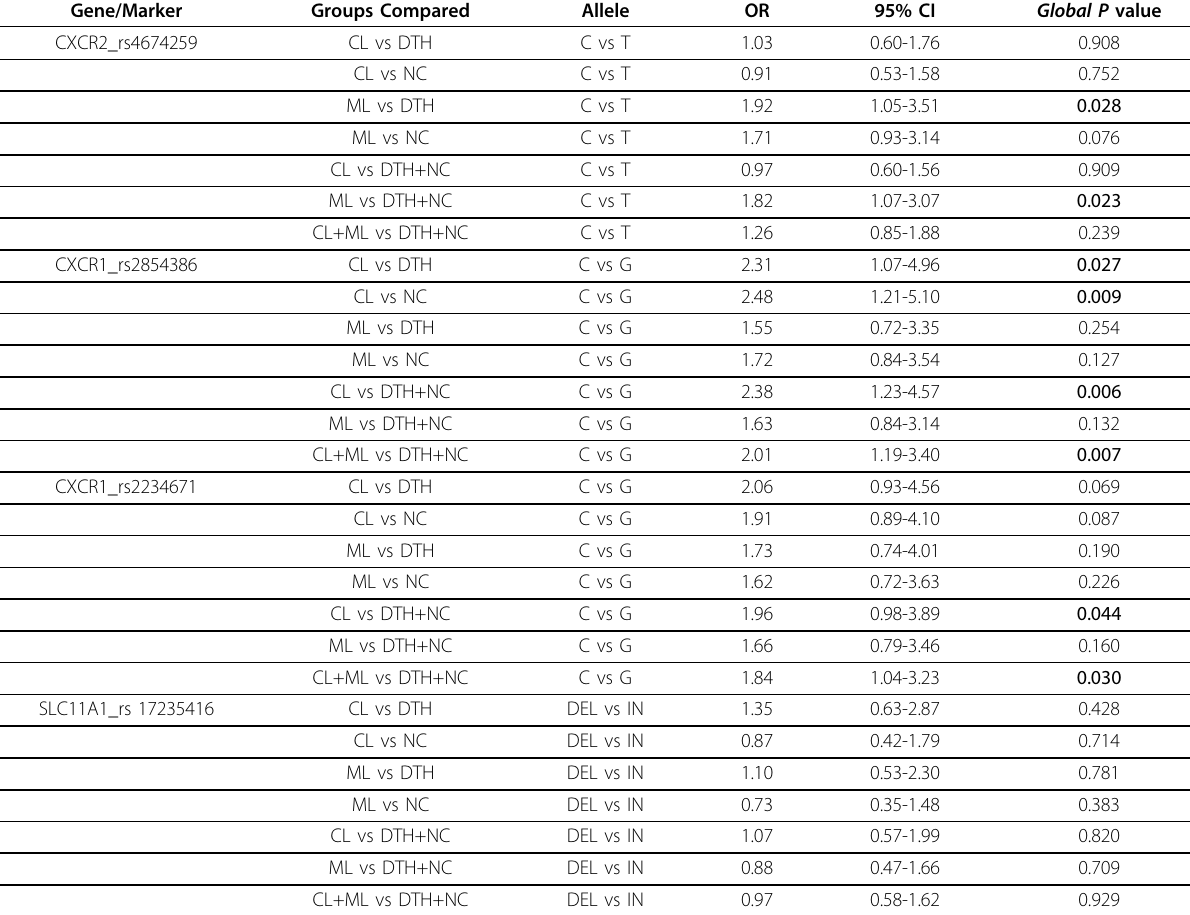
Table 2 Results of logistic regression analysis Gene/Marker Groups